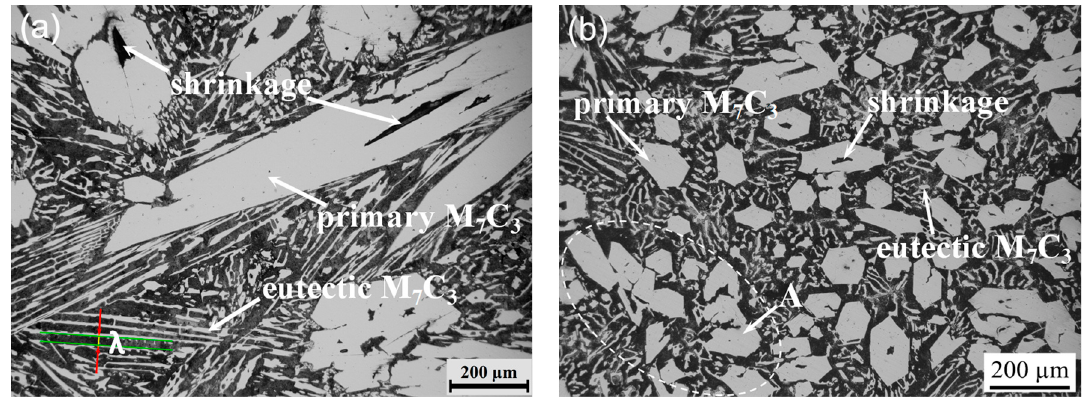
Figure 2. Optical micrographs of solidification microstructure of hypereutectic HCCI with or without ECP treatment: ( a ) Non-ECP treatment; ( b ) ECP treatment.